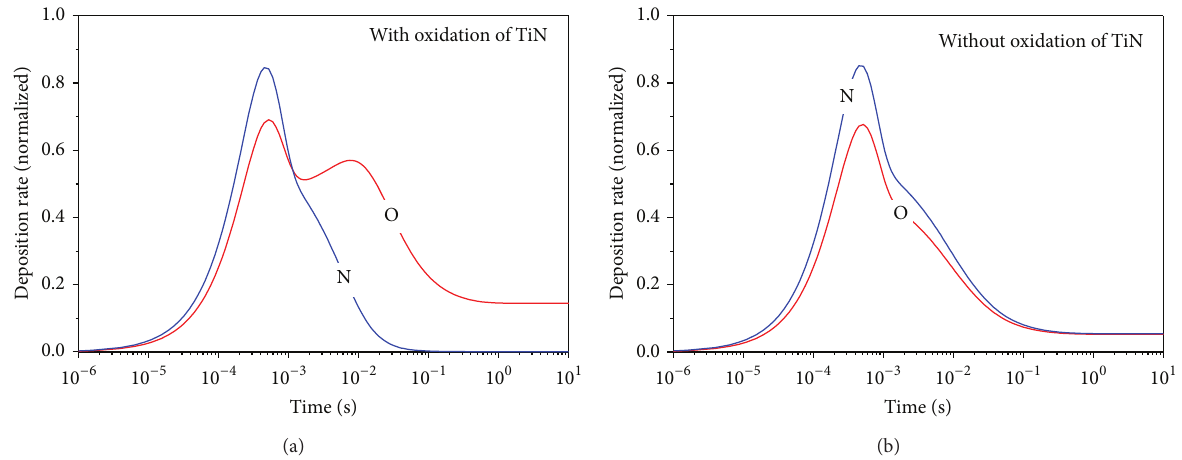
Figure 4: Deposition rate at oxygen flow rate of 3.5 sccm for the cases (a) with and (b) without oxidation of the nitride layers.